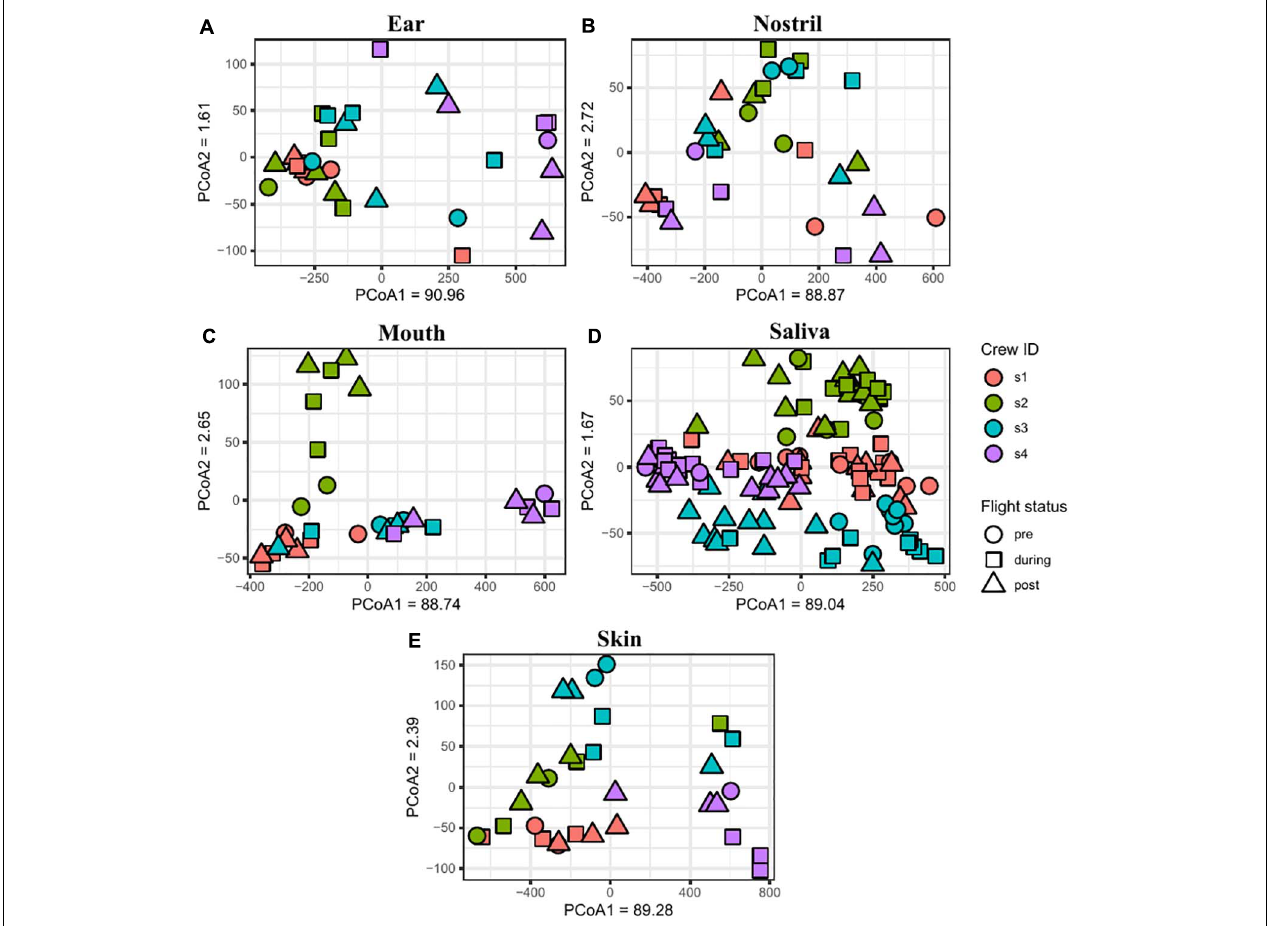
FIGURE 7 | PCoA plots depicting the Euclidean distance between samples. Ear (A) , nostril (B) , mouth (C) , saliva (D) , and skin (E) samples are shown grouping by astronaut (s1, red; s2, green; s3, blue; s4, purple) and flight status (pre, circle; during, square; post